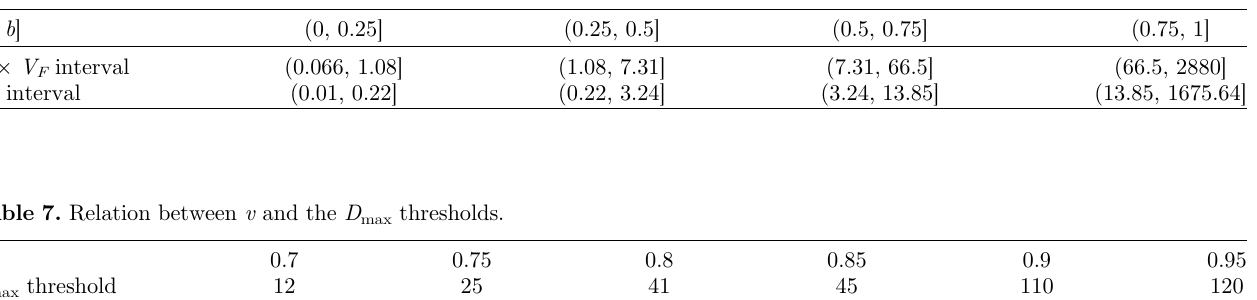
Table 6. Relation between the intervals ( a , b ] and the dam factor intervals.